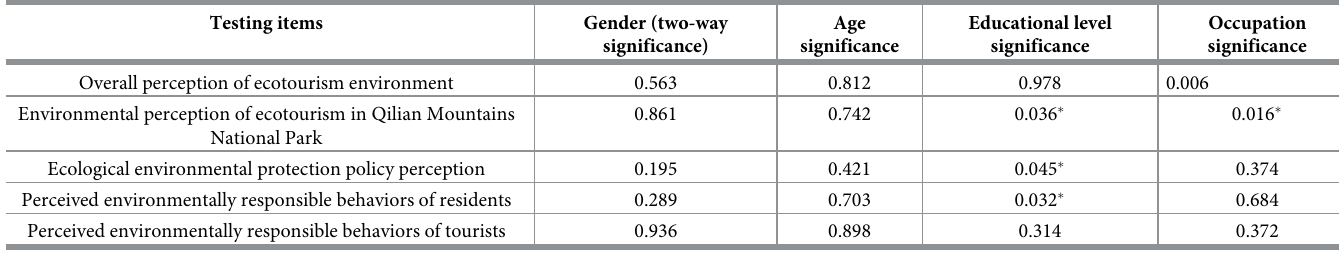
Table 13. The test results of significant differences in tourists’